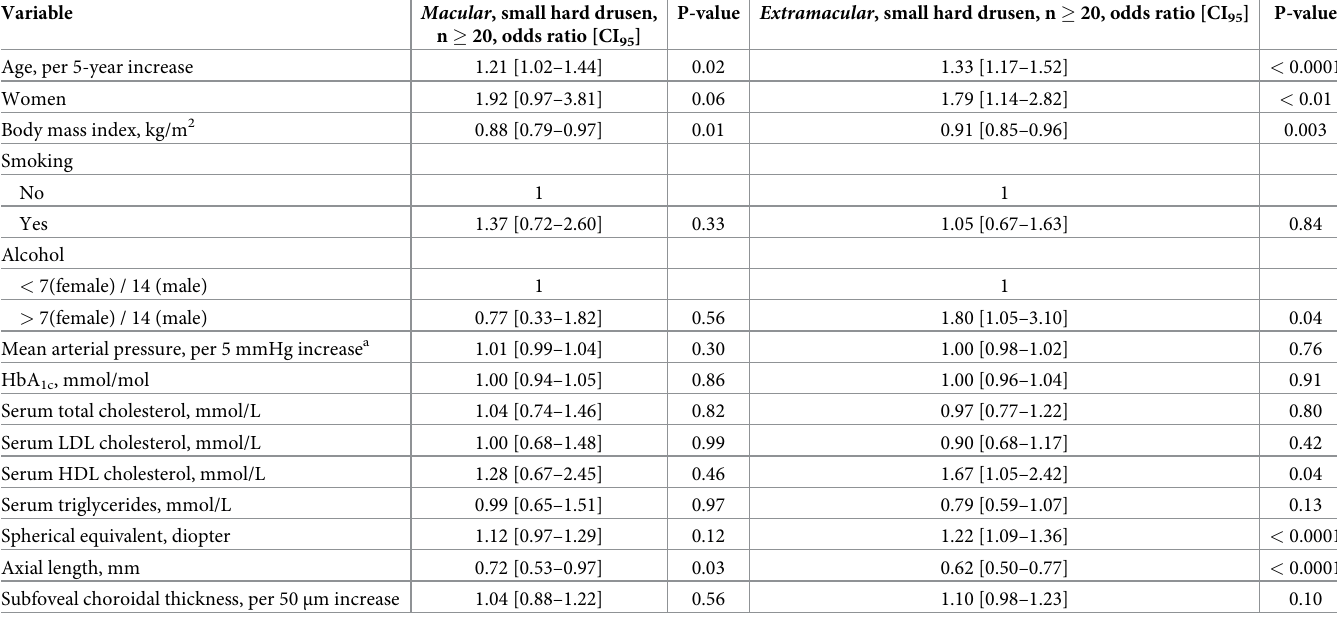
Table 4. Multivariable conditional logistical regression model of variables associated with � 20 small hard macular drusen per eye and � 20 hard extramacular dru- sen per eye. Variable